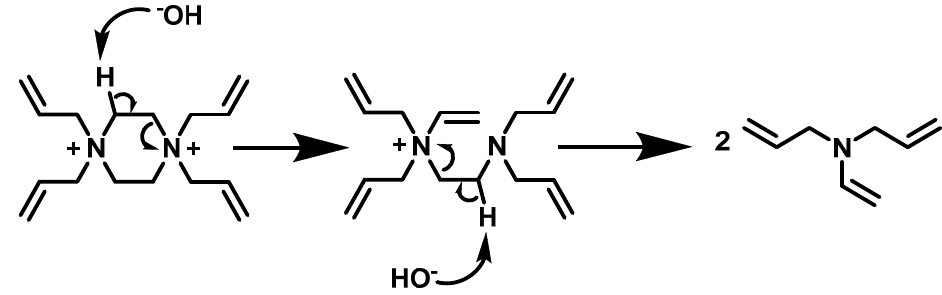
Figure 3. Potential beginning of the alkaline degradation of TAPB ( 1b ) by Hofman-type elimination.